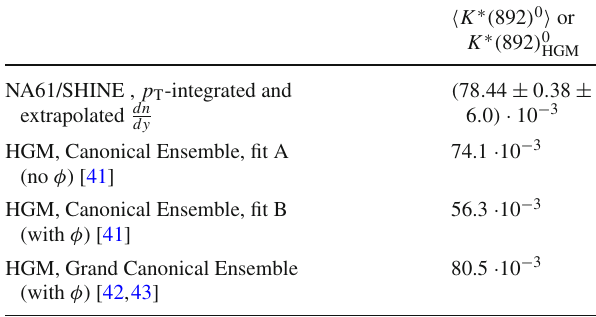
Table 7 The mean multiplicity of K ∗ ( 892 ) 0 mesons for 158 GeV / c inelastic p+p interactions compared to theoretical multiplicities obtained within Hadron Gas Models